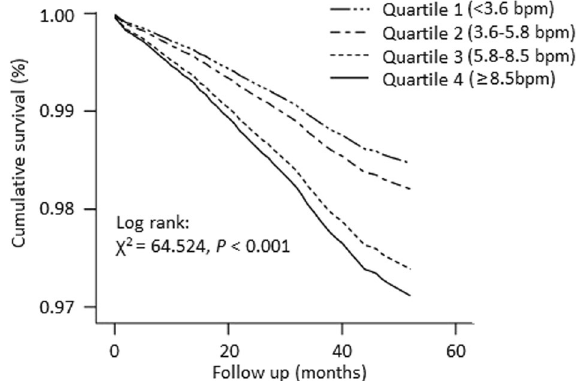
Figure 2. The Kaplan-Meier survival curves for all-cause mortality by quartiles of standard deviation of resting heart rate.